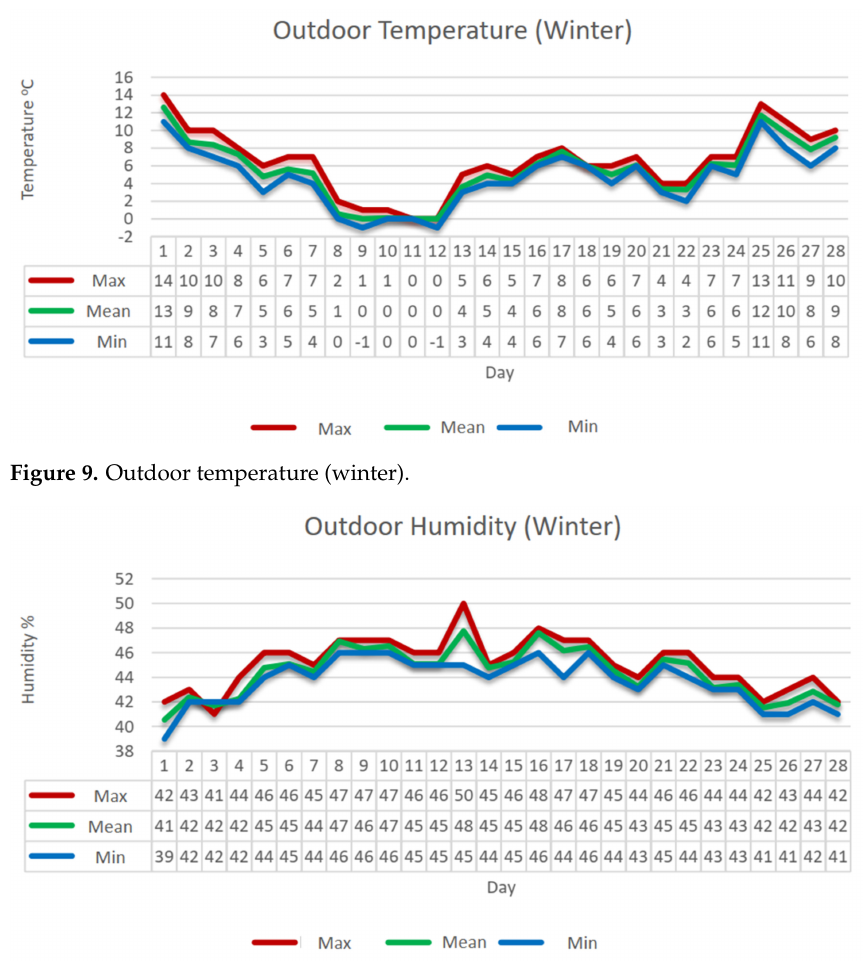
Figure 10. Outdoor humidity